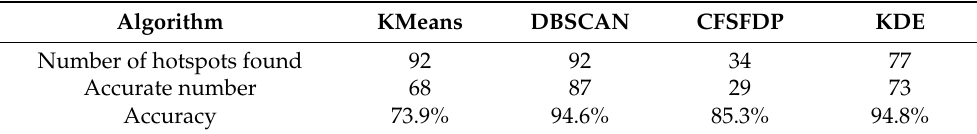
Table 5. Verification of the accuracy of hotspot